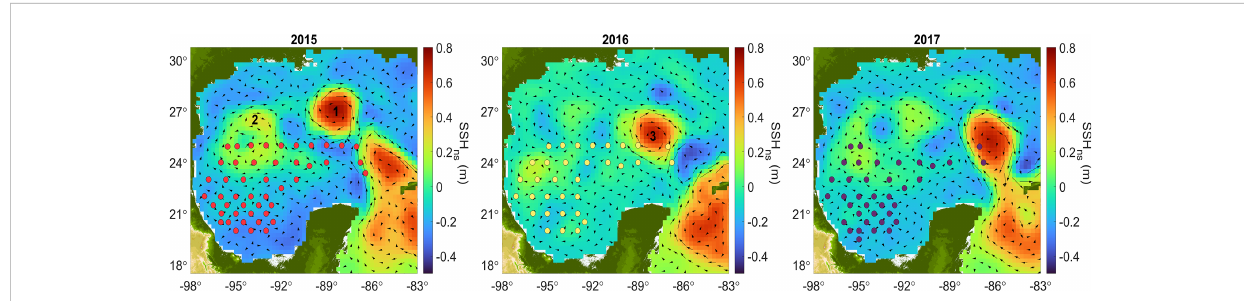
FIGURE 3 Mean non-steric sea surface height (SSH ns ) for the GoM during 2015, 2016, and 2017 cruises. Arrows represents geostrophic velocities. 1: Olympus. 2: Nautilus remnants. 3: Poseidon. Circles represent stations sampled during each